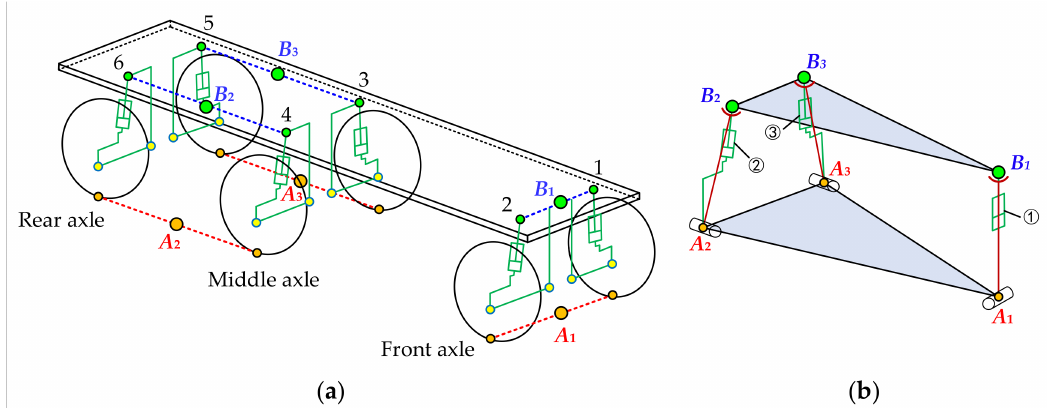
Figure 6. Construction of equivalent 3-DOF parallel mechanism for three-axle vehicle: ( a ) Grouping and interconnection of the suspension units; ( b ) equivalent 3-DOF parallel